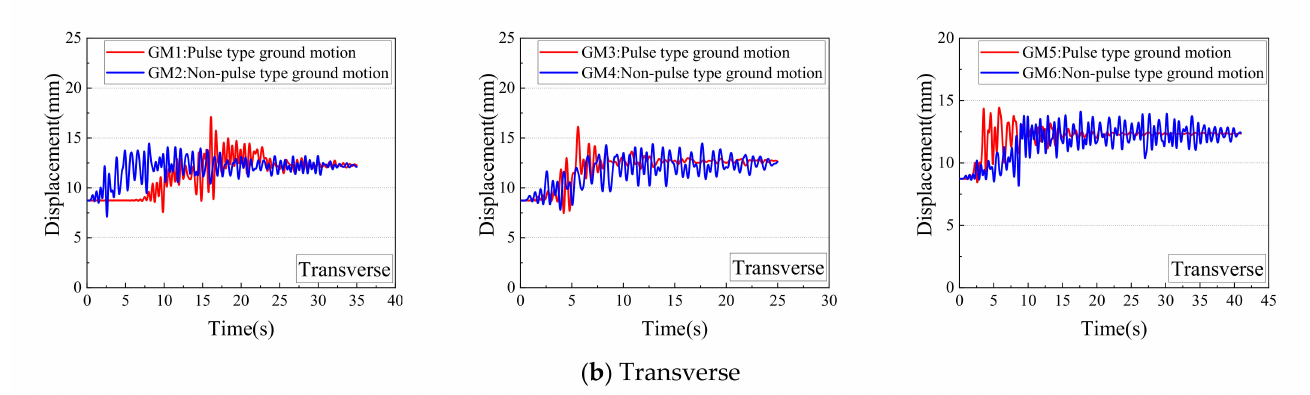
Figure 9. Displacement time-history of the abutment under pulse and non-pulse type ground motions (Model